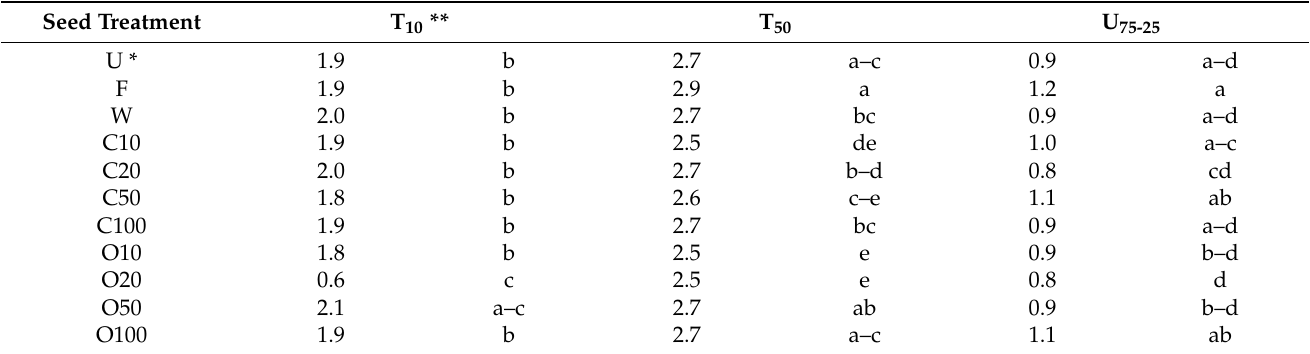
Table 4. Effects of coconut and oregano hydrolates treatment on the speed and uniformity of seed germination of onion seeds of sample II